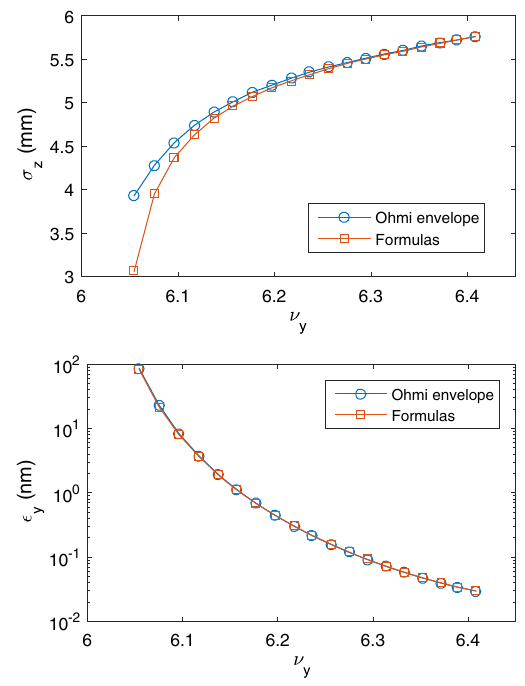
FIG. 5. Minimum pulse duration vs vertical tune for the low emittance lattice and the achromat lattice of SPEAR3. Filled markers indicate nominal tunes for